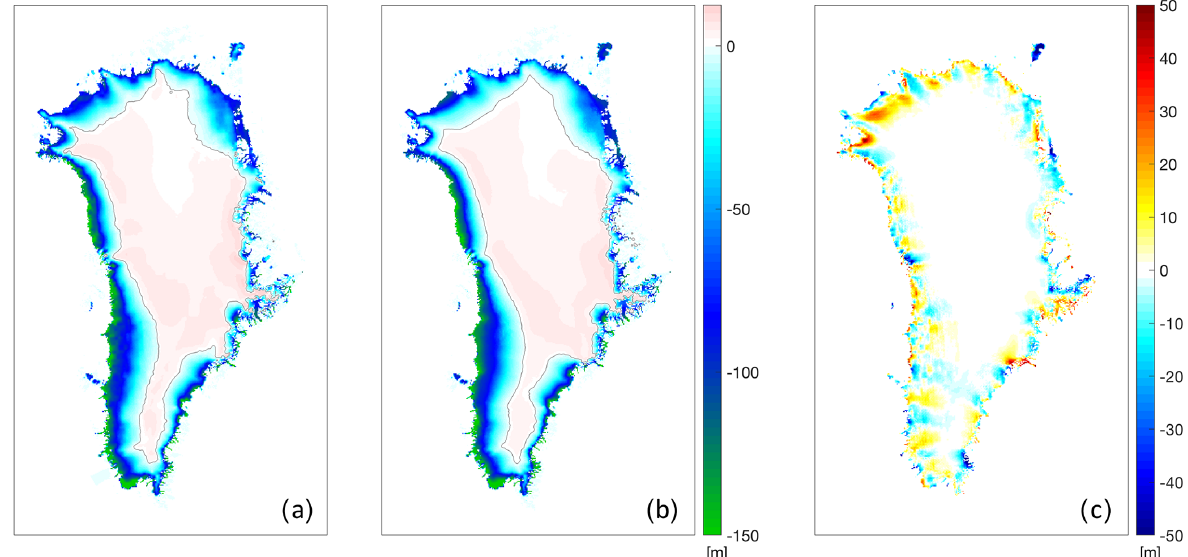
Figure 10. (a) Time-integrated aSMB for MOD, (b) MAP, and (c) MAP–MOD differences, representing the error of the remapping. The zero line is given in (a) and (b) as a grey